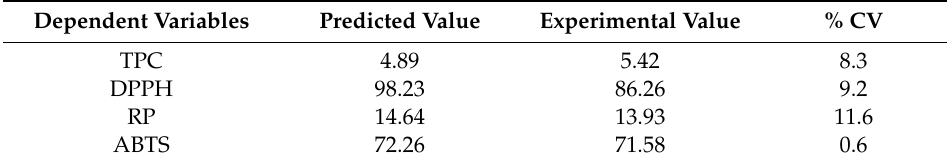
Table 4. Experimental data of the validation of predicted values at optimal extraction conditions. Dependent Variables